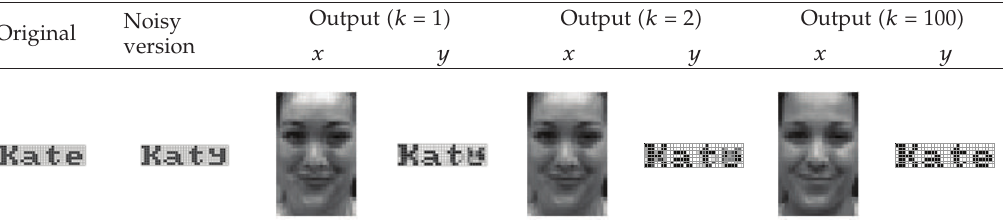
Table 3: Network recall for an incorrect